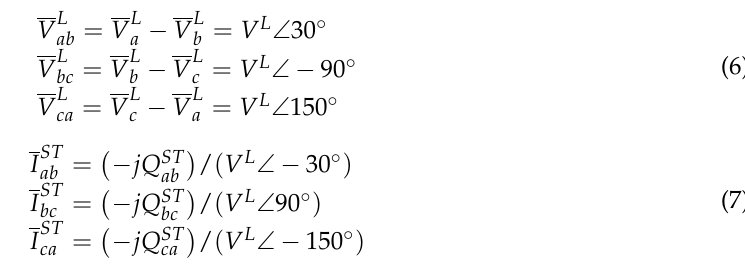
Figure 2. Three-phase, three-wire unbalanced load and the